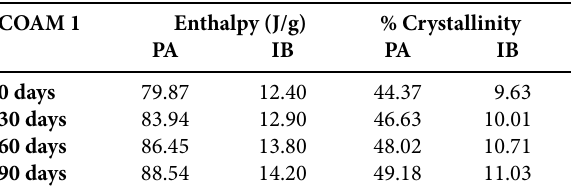
Table 3. Enthalpy and % crystallinity of COAM 1 after a) 0 days, b) 30 days, c) 60 days and d) 90 days (accelerated stability samples)